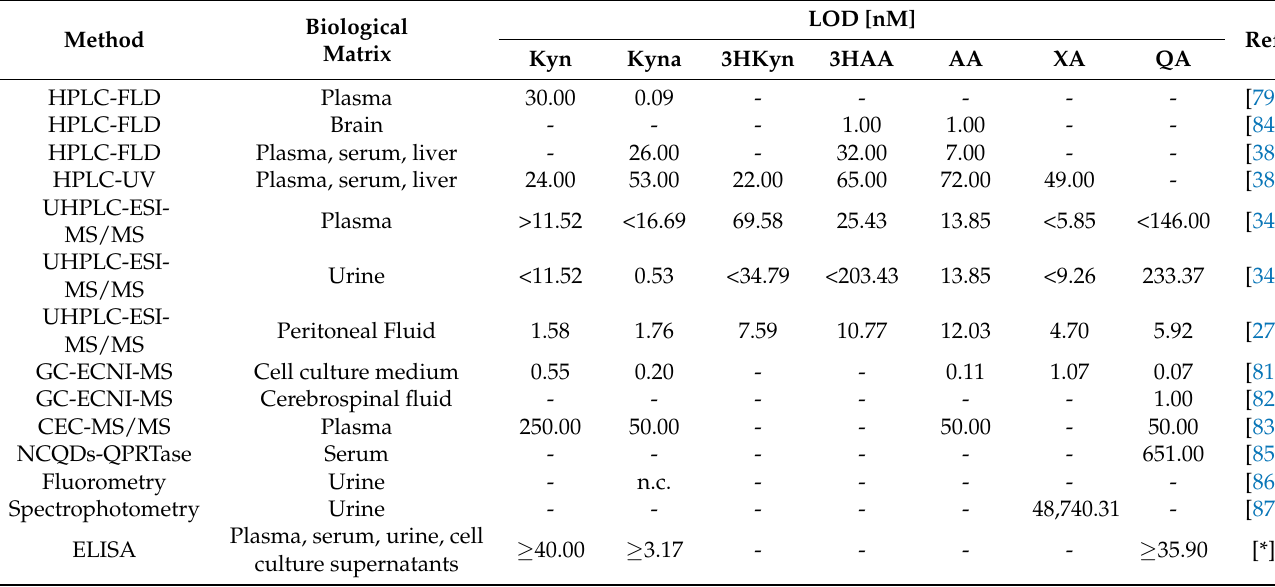
Table 3. Analytical methods used for kynurenine pathway metabolites’ determination in biological samples (excluding methods with electrochemical